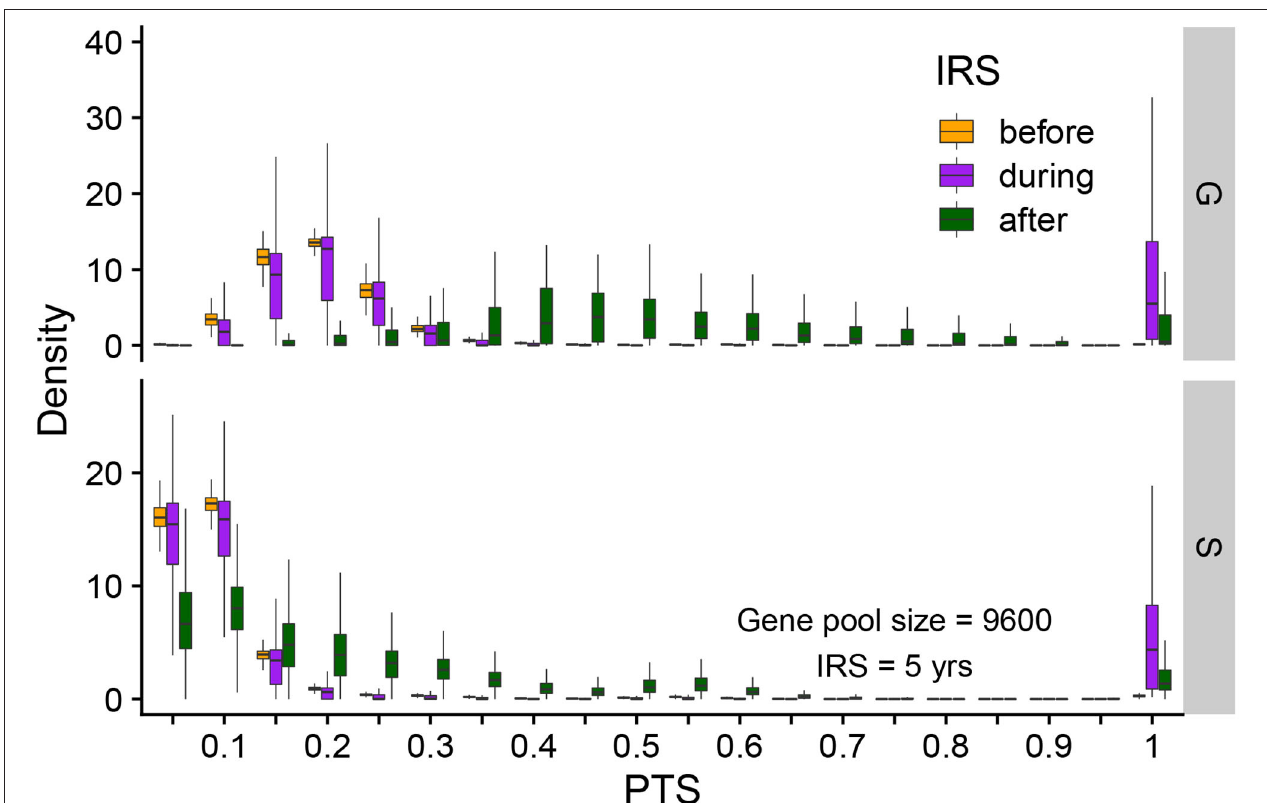
FIGURE 4 | Distribution of pairwise PTS for var repertoires before (orange), during (purple), and after (green) intervention under S and G. PTS values are binned into 40 equally-sized bins (of 0.05). Each box shows the variation of PTS values across different runs. Summarized here are runs from a gene pool size of 9,600, high transmission and a 5-year intervention. The PTS distributions differ between G and S. After intervention, the PTS distribution in G drifts away from its initial state, whereas that in S tends to go back to its pre-IRS